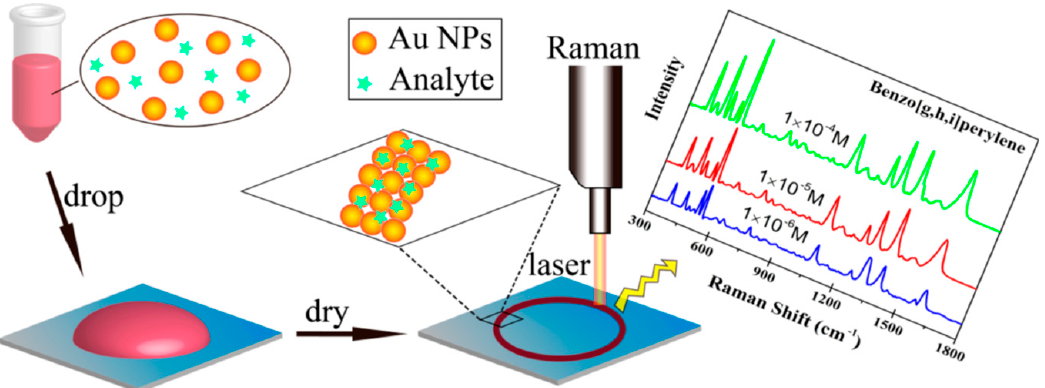
Figure 1. Facile detection of PAHs by a SERS based on the Au coffee ring effect. Reproduced from ref. [86], with permission from American Chemical Society, 2014.